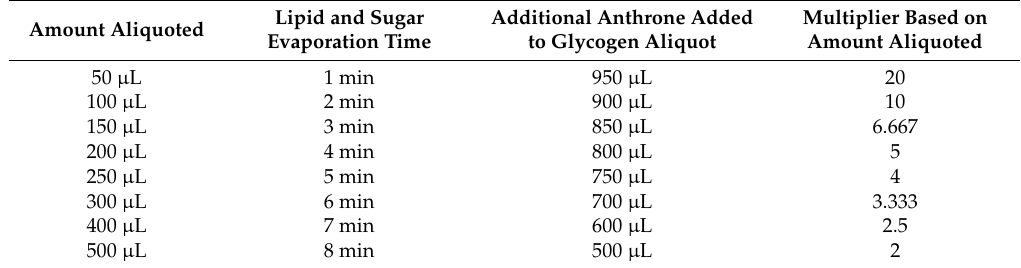
Table 2. The evaporation time for lipid and sugar reading, amount of additional anthrone added for glycogen reading and multiplier based on amount aliquoted for a BMSB